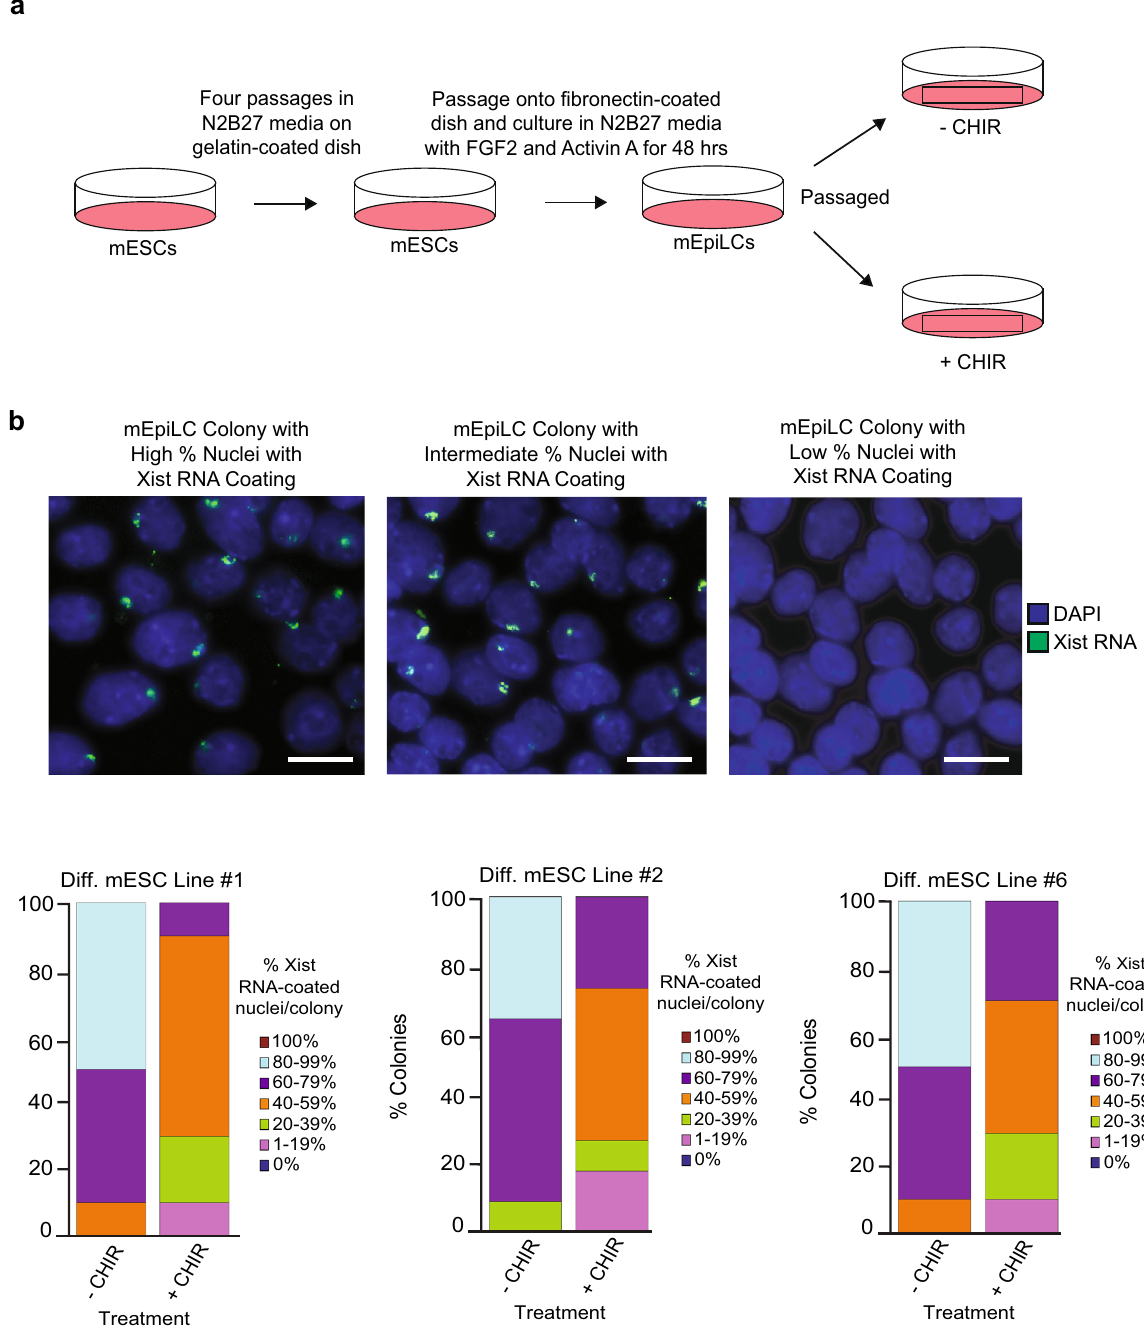
Fig. 9 GSK-3 Inhibition and Loss of Xist RNA Coating in Differentiating Female mESCs. a Strategy for the differentiation of mESC lines into mEpiLCs and culture of mEpiLCs with and without the GSK-3 inhibitor CHIR99021 (CHIR; 3 μ M). b Representative images of mEpiLCs with high, intermediate, and low percent of nuclei with Xist RNA coating (green). Nuclei are stained blue with DAPI. At least ten nuclei were counted per colony in mEpiLC RNA FISH quanti fi cation. Scale bars are ~100 microns. c Percentage of nuclei with Xist RNA coating in differentiating mEpiLCs with and without CHIR generated from three independent ESC lines. mEpiLCs cultured with CHIR lost a signi fi cant proportion of Xist RNA coating compared to mEpiLCs cultured without CHIR in all three mEpiLC replicates (general linear model comparison, p < 0.001). At least ten nuclei were counted per colony for mEpiLC RNA FISH quanti fi cation. The total number of colonies quanti fi ed at each passage range between 12 and 20 and are cataloged in source data. Source data are provided as a Source Data fi